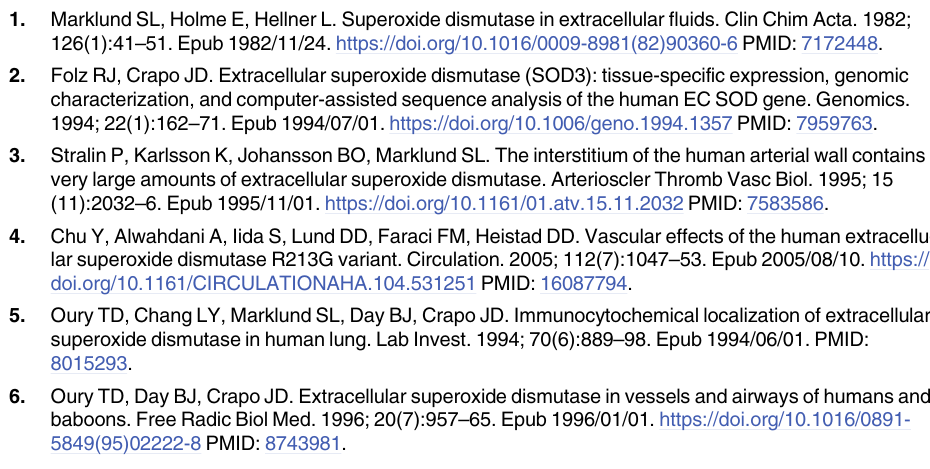
, compared with those of SOD3 in R213G